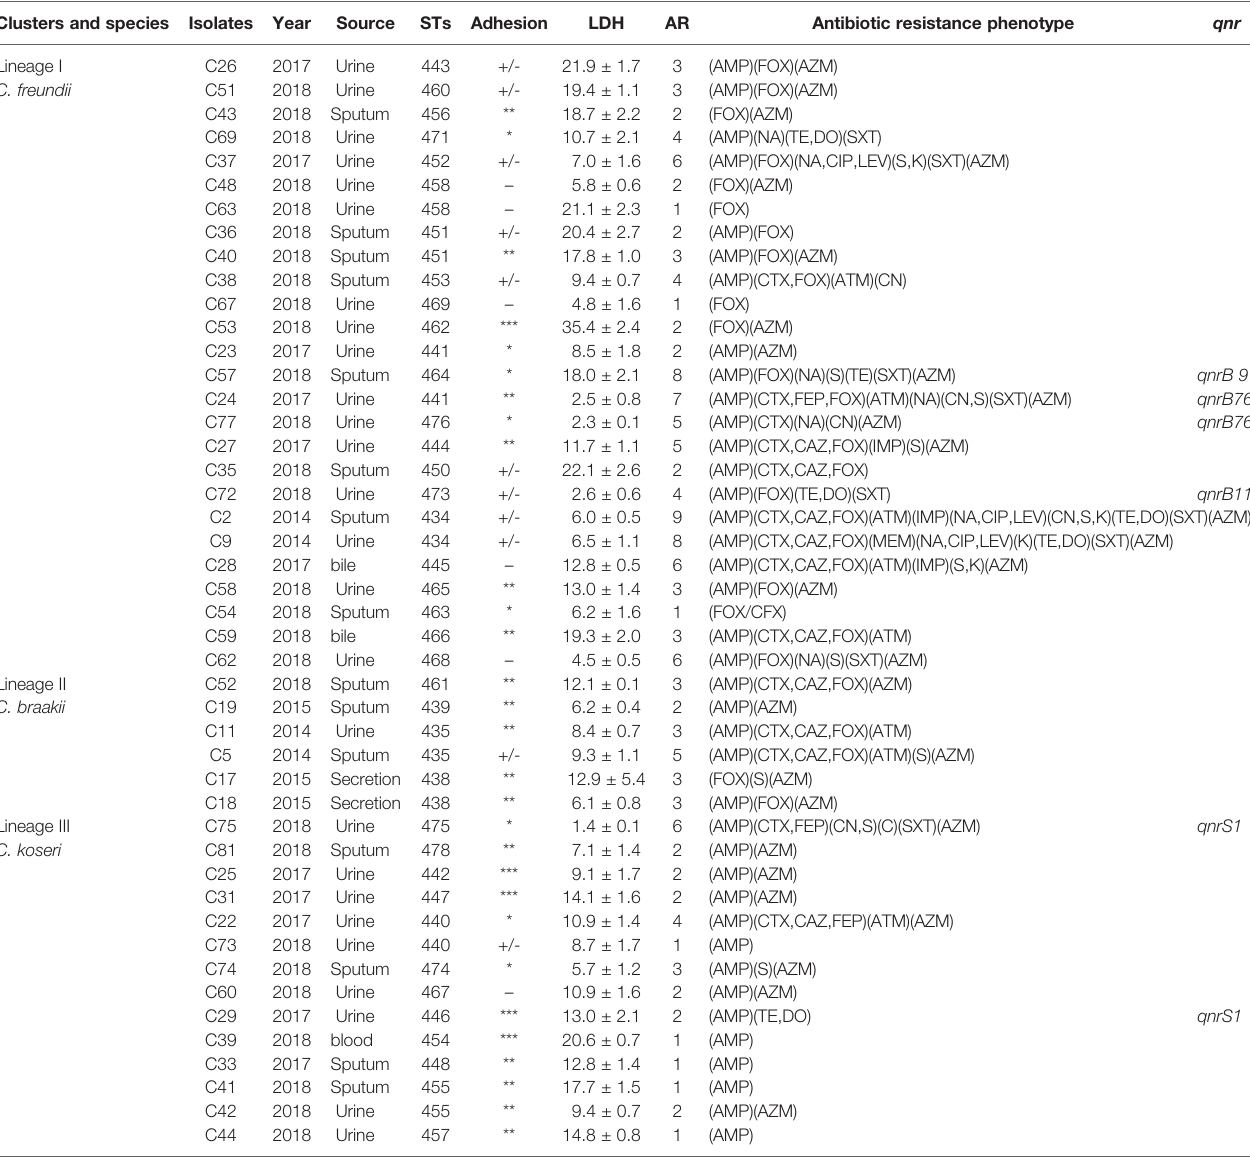
TABLE 2 | Adherence, cytotoxicity, source, antibiotic resistance, genotypes, and antibiotic resistance phenotype of Citrobacter isolates. Clusters and species Isolates